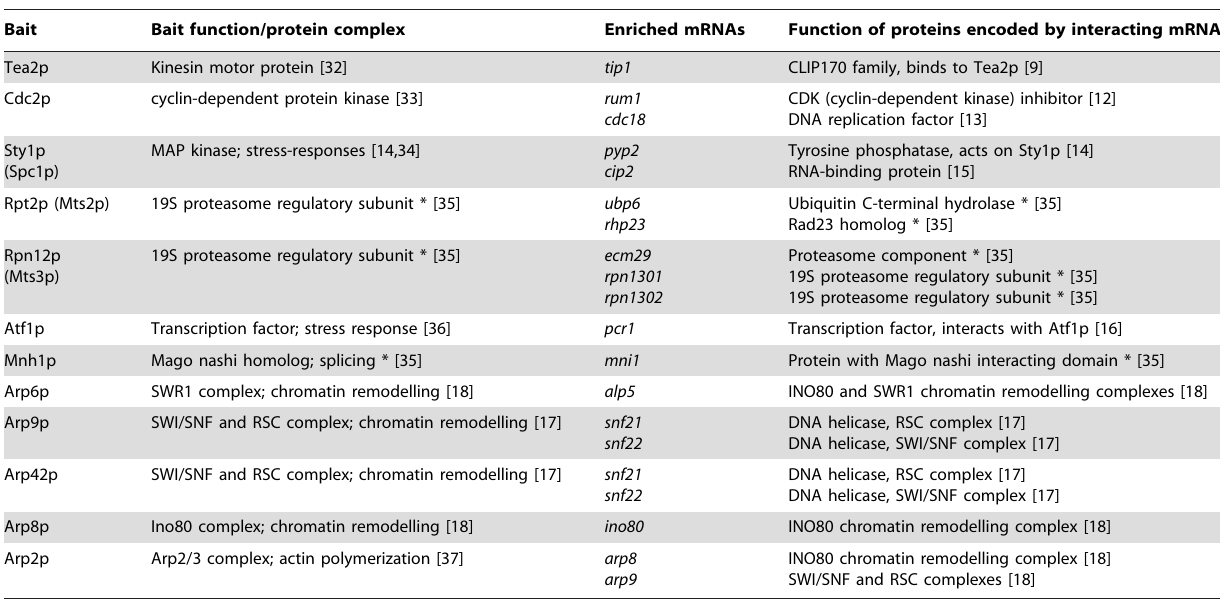
Table 1. Proteins analysed by RIp-chip and mRNAs associated with them.